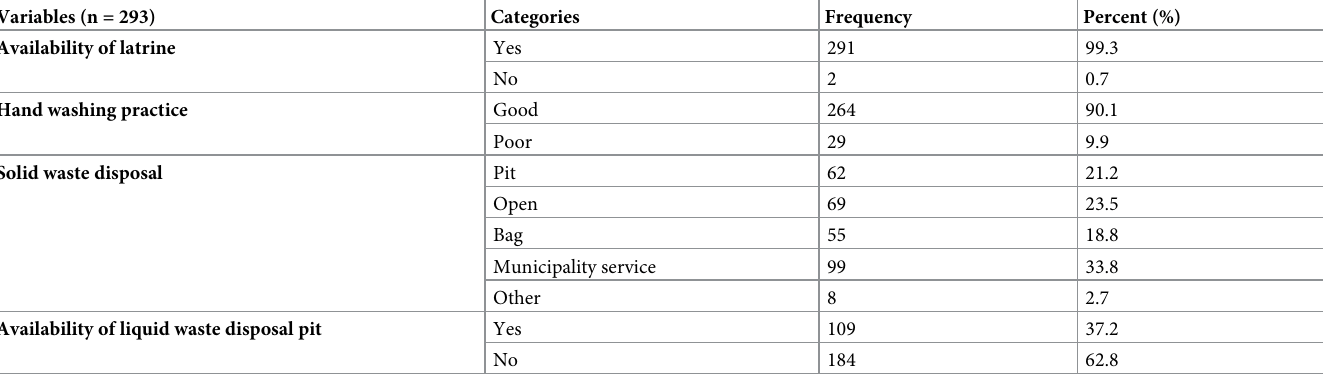
Table 3. Environmental health-related characteristics of study participants in Wolkite town,